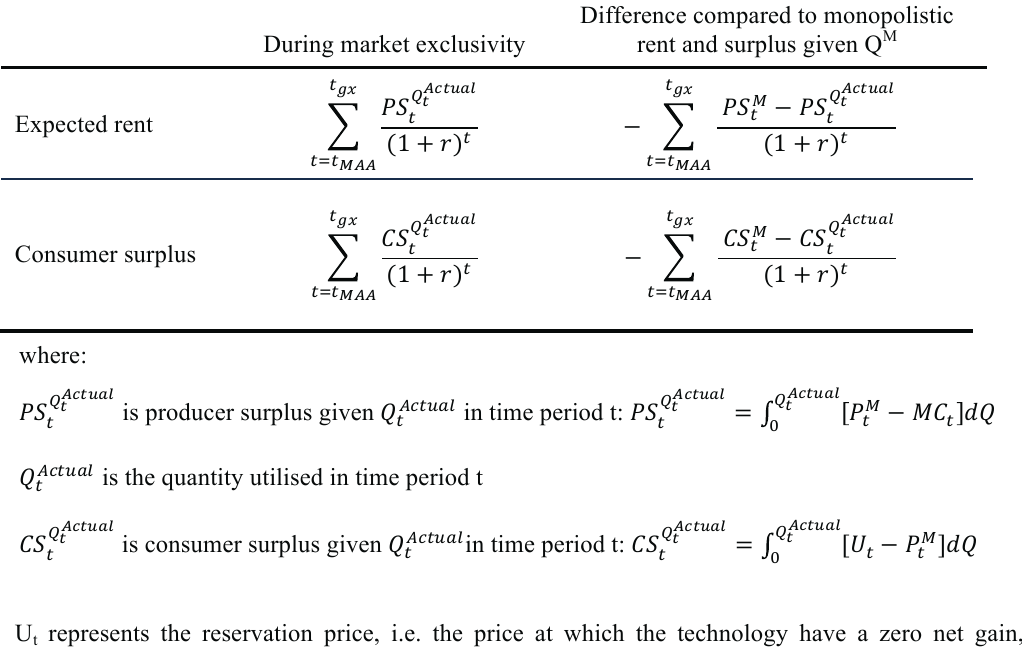
Difference compared to monopolistic rent and surplus given Q M